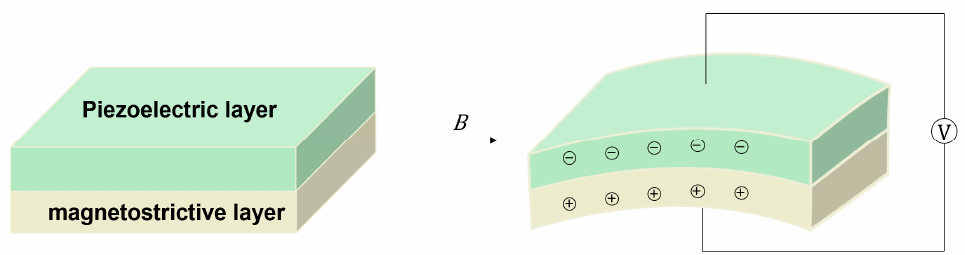
Figure 15. Working principles of ME sensor.